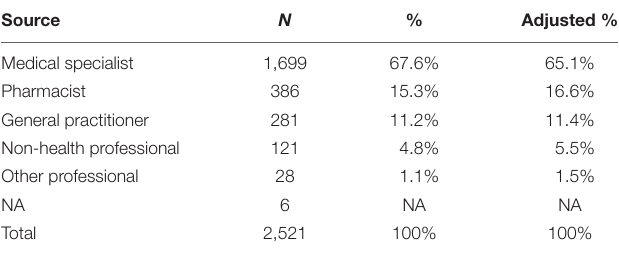
TABLE 2 | Reporters of the cases in the FPVD.